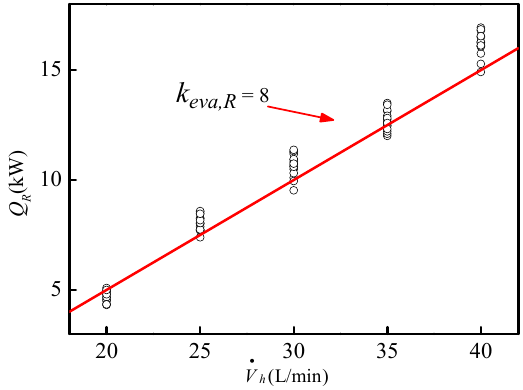
Figure 11. Heat transfer gain coefficient.